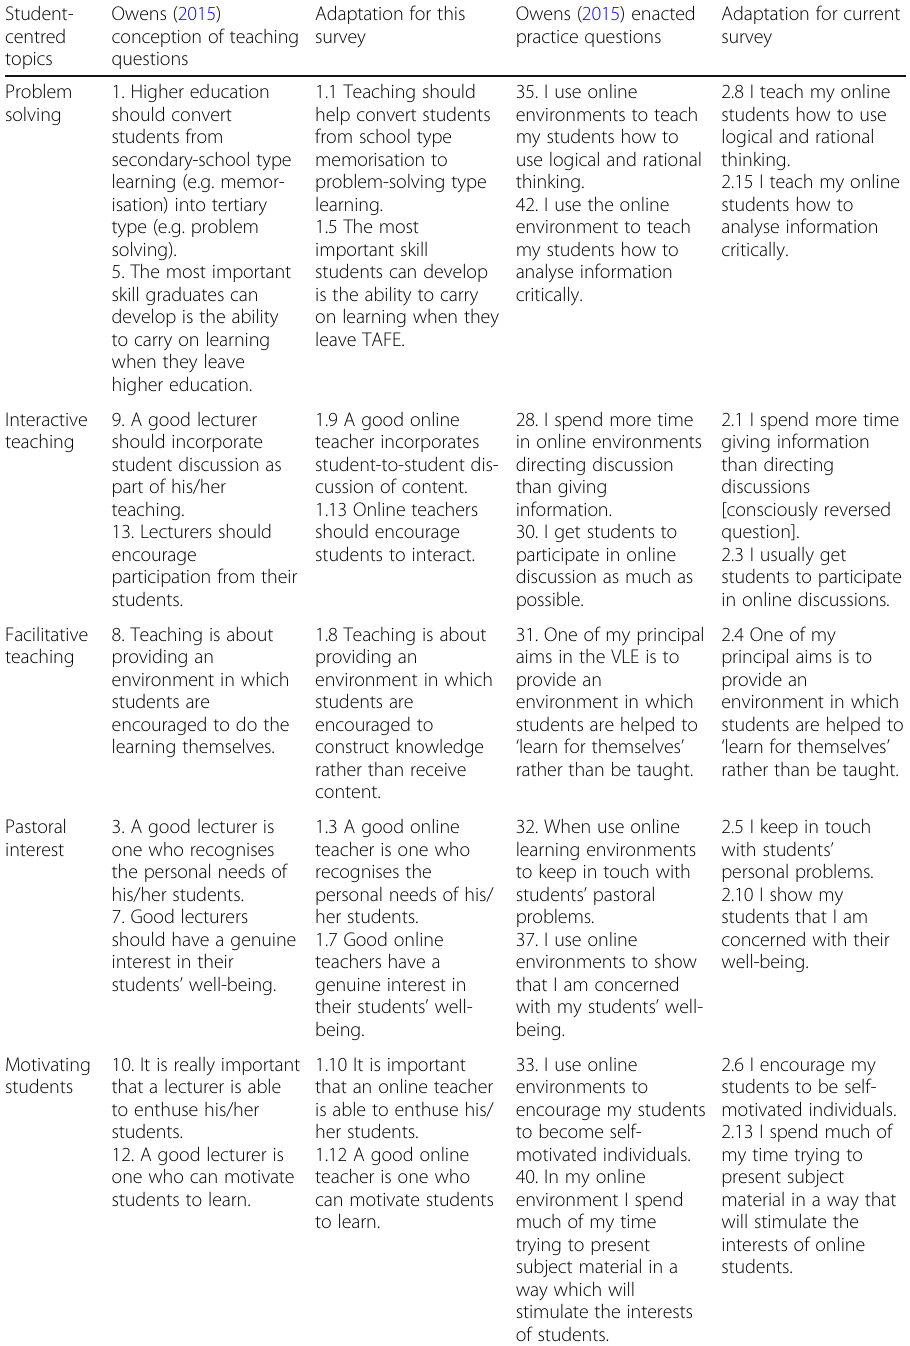
Table 9 Approach one to identifying conceptions of teaching and enacted practice. Adaptation of student-centred questions from Owens (2015) Student- centred